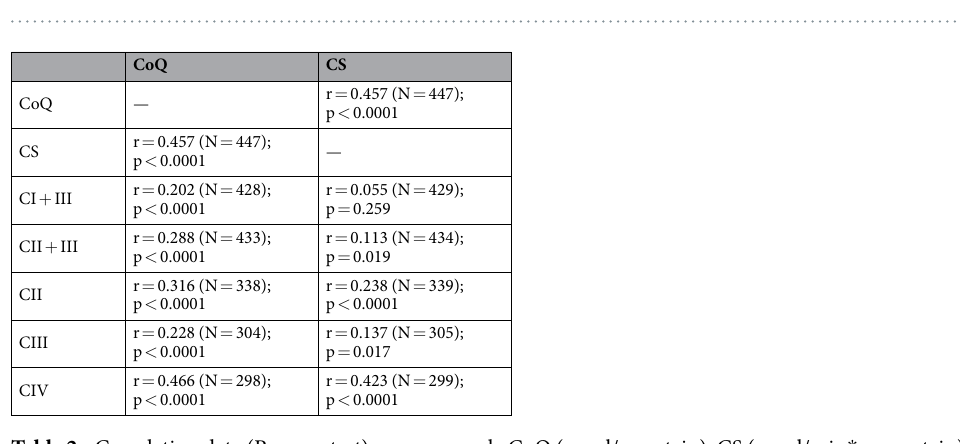
Table 2. Correlation data (Pearson test) among muscle CoQ (nmol/g protein), CS (nmol/min * mg protein) and MRC activities (nmol/min * mg protein) from the whole